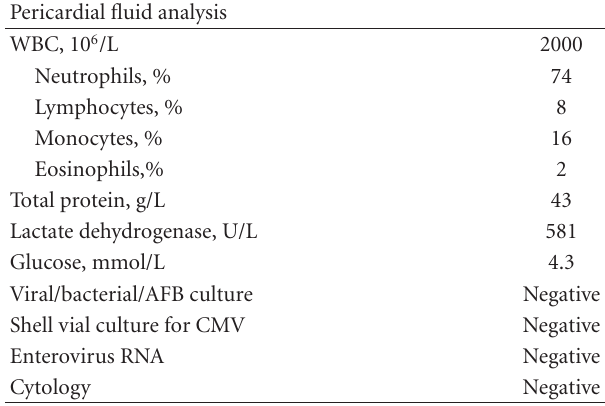
Table 2: Laboratory data on pericardial fluid.